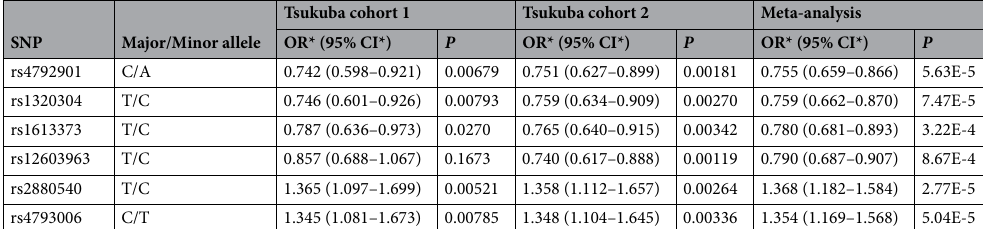
Table 2. Case–control association studies and meta-analysis. Associations between each SNP and asthma were examined by logistic regression analysis adjusted for gender, age, and smoking status (never, ex-, and current smoker). OR odds ratio, CI confidence interval. *ORs and 95% CIs were calculated by using a major allele as the